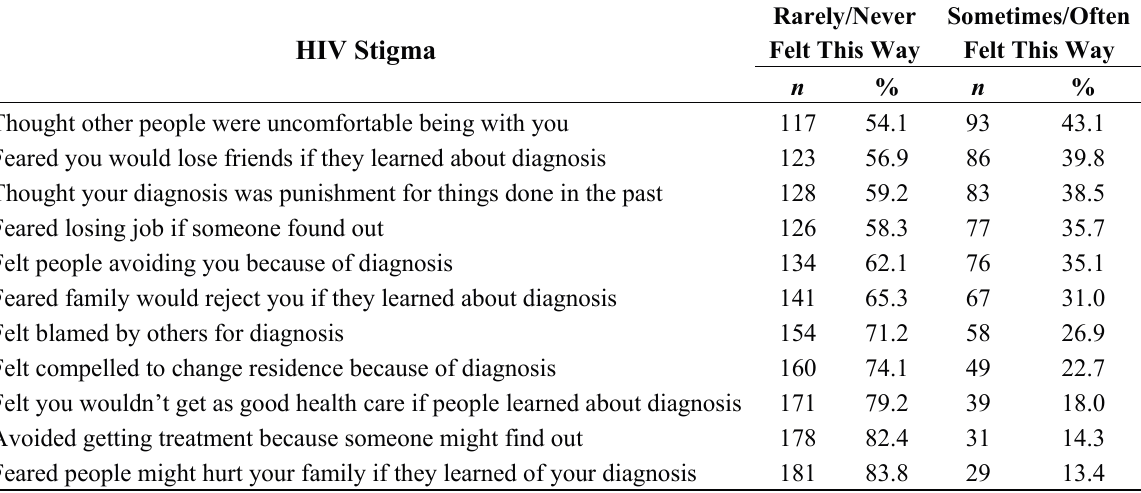
Table 4. HIV Stigma Scale Responses among Respondents Who Received ARVs within the Past 12 Months ( n =